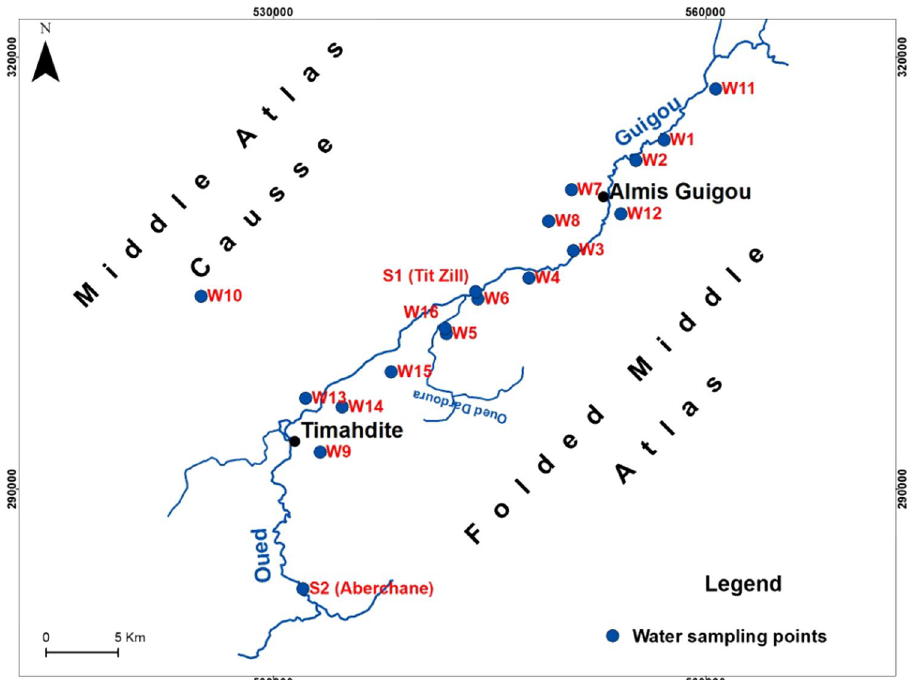
Fig. 3 Representation of water sampling points in the study